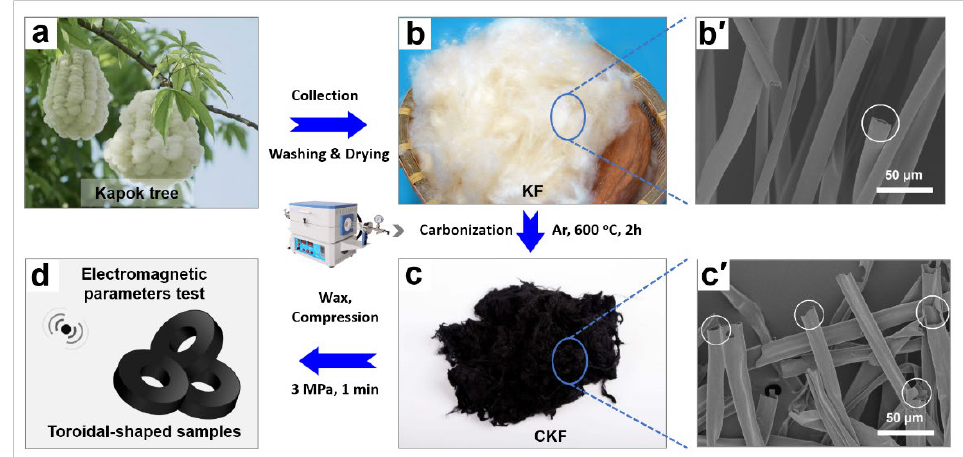
Figure 1. Schematic description of the fabrication of KF-derived carbon microtube for microwave attenuation.